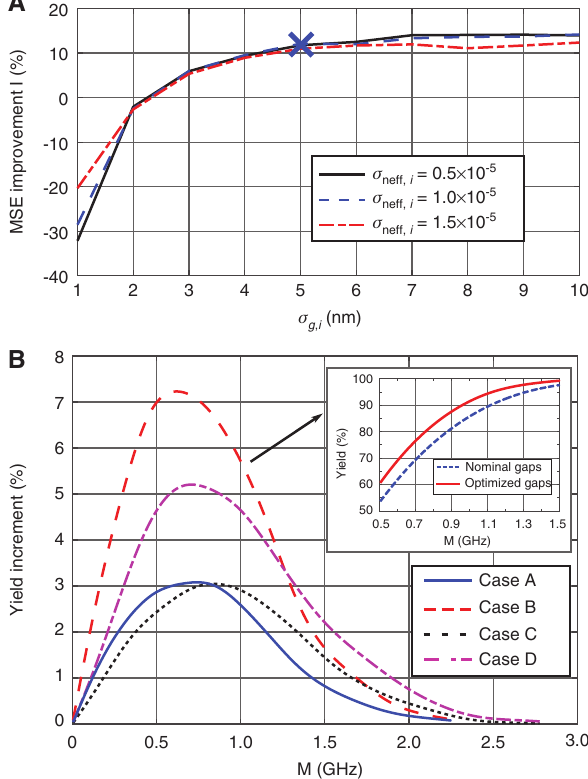
Figure 7: (A) MSE improvement for the optimized design of case A as a function of the σ and σ , where the process variations on g,i neff, i the gaps and effective phase indices are assumed to be Gaussian distributed with zero mean and standard deviation σ and σ , g,i neff, i respectively. The blue cross represents the MSE improvement for σ and σ used in case A. (B) Yield increment of the optimized g,i neff, i designs in cases A–D as a function of M , where 2 M is the width of + M the bandwidth acceptance interval [BW - M , BW 0 0